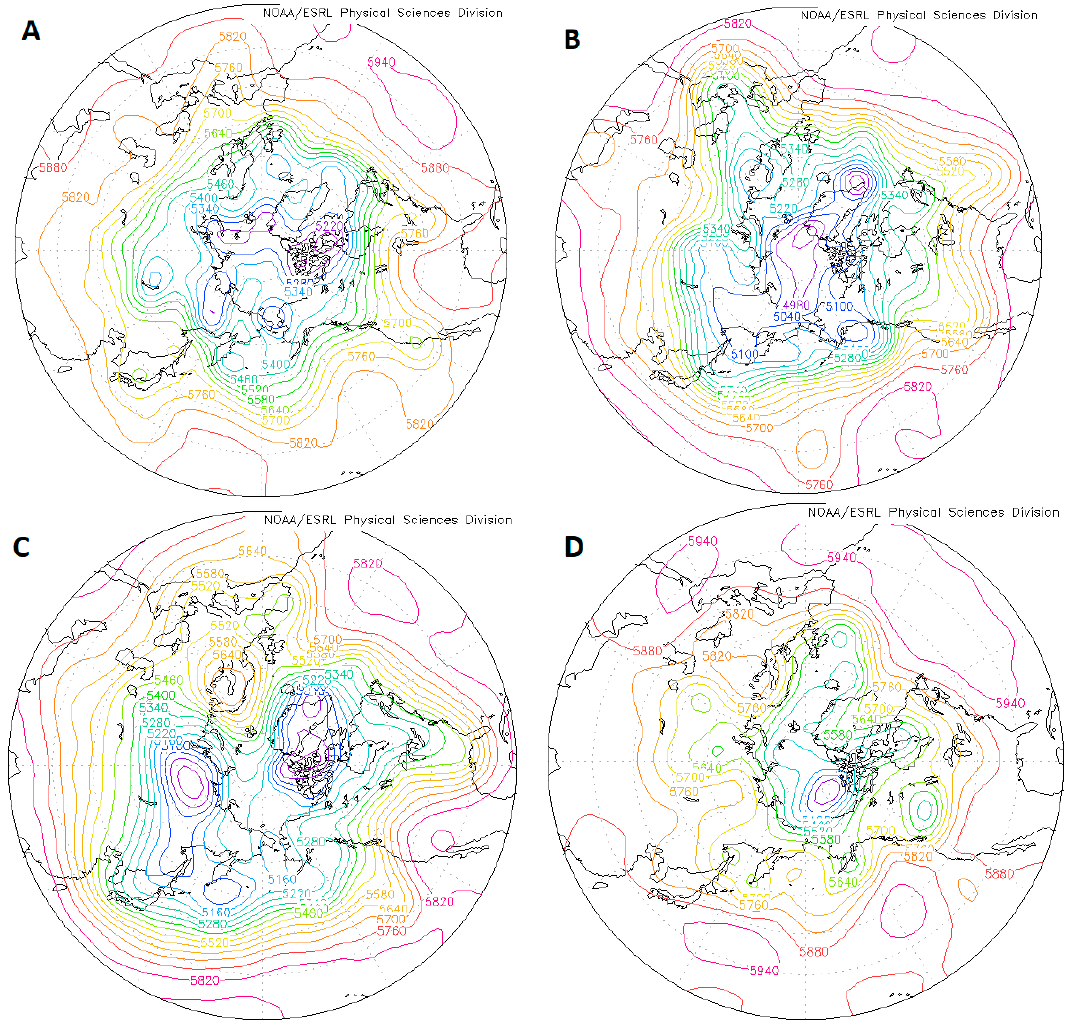
Figure 2. Examples of the large-scale circulation types using the 1200 UTC 500 hPa height field. The contour interval is 60 m and in color. The given examples are ( A ) Type 1 (6 October 2006 AO = 0.124), ( B ) Type 2 (8 March 2006 AO = 1.76), ( C ) Type 3 (6 January 2006 AO = − 1.64), and ( D ) Type 4 (13 July 2013 AO = 0.28).